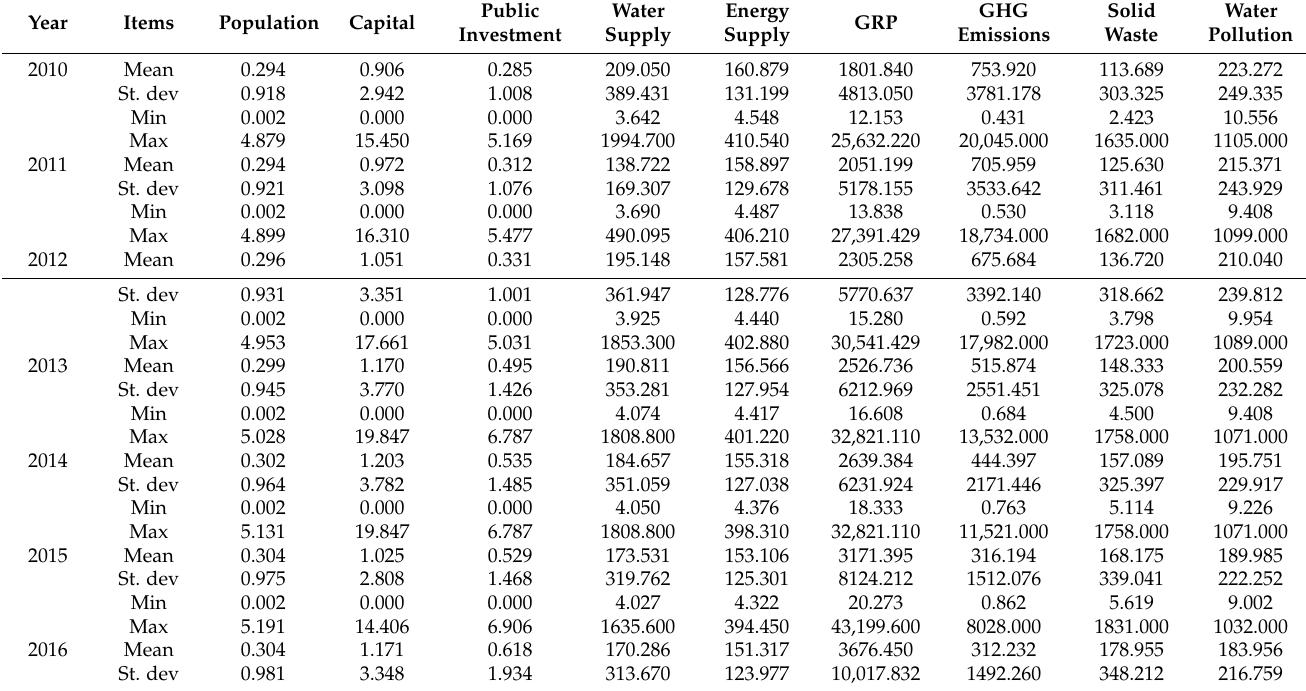
Table 2. Descriptive statistics of the inputs and outputs of models.